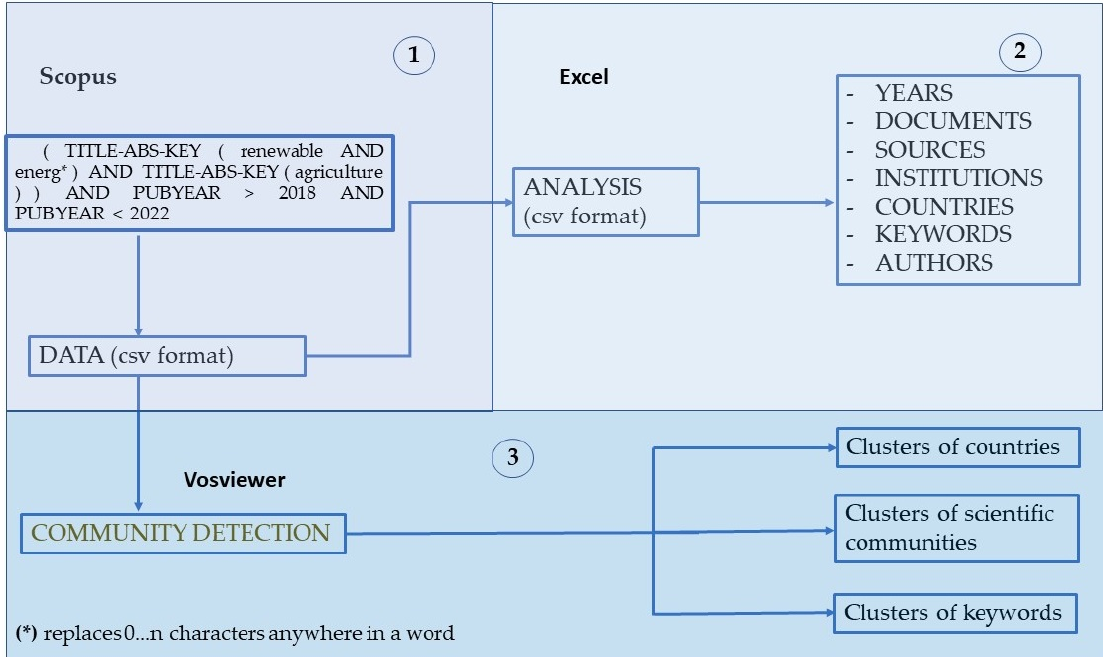
Figure 1. Methodology